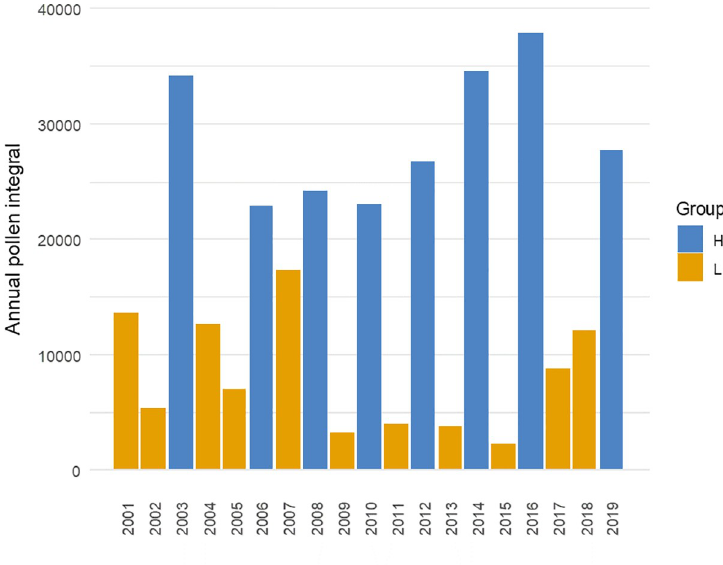
Fig 5. Annual pollen integral for the divided subsets—high concentration (H) and low concentration (L) of Betula pollen in atmospheric air.